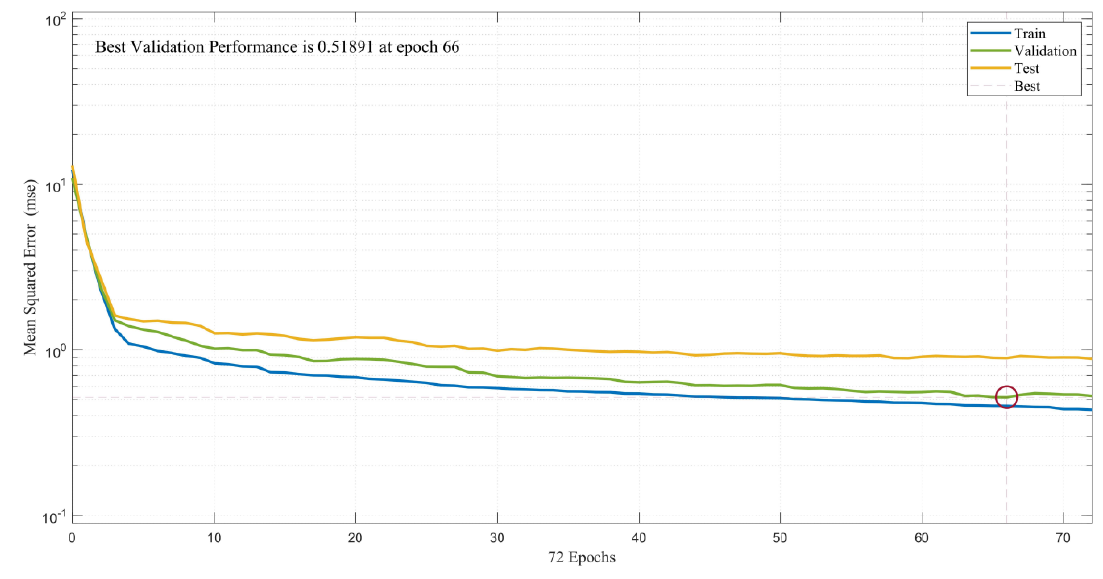
Figure 12. SCG model performance.